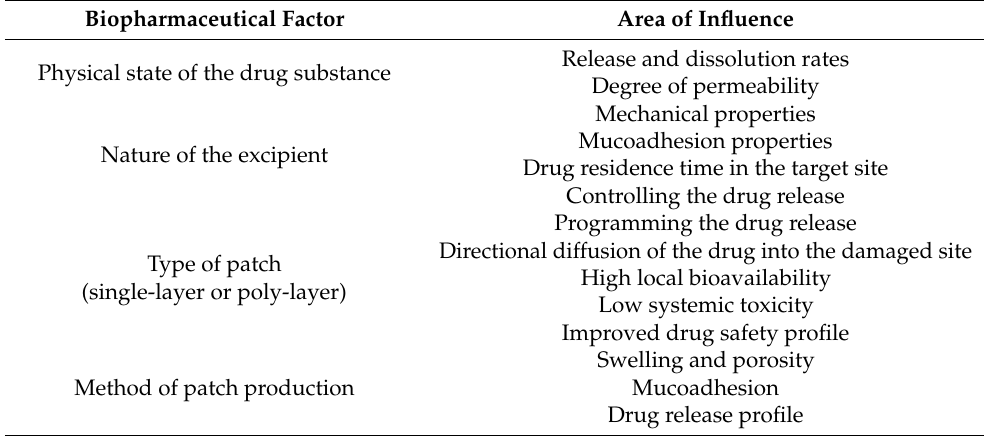
Table 2. Effect of biopharmaceutical factors on the effectiveness of patches as a modified dosage